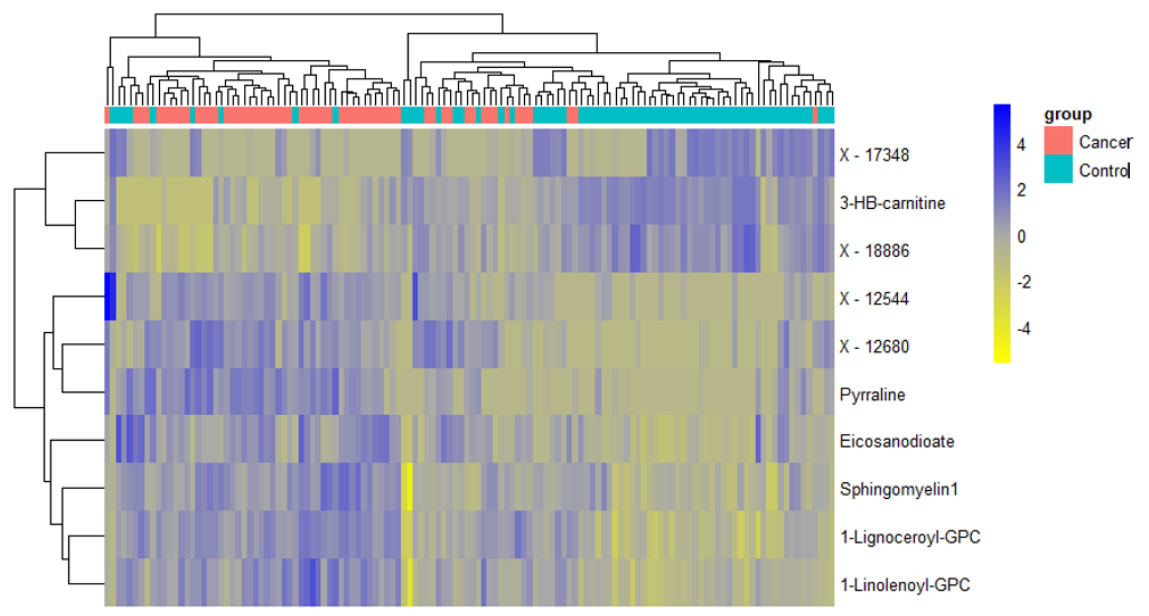
Figure 8. Hierarchical clustering using the top 10 discriminatory metabolites for the detection of early-stage endometrial cancer in the training set ( n = 102, cancers = 47, controls = 55) based on mean decreasing accuracy using random forest classification algorithm. The difference in intensities of the top 10 metabolites by cancer-control status is shown. Each coloured cell in the map represents scaled/relative concentration of indicated metabolite. Metabolites are clustered along the vertical axis while subjects are clustered along the horizontal axis. Metabolites starting with X are unnamed; the pathways of these are unknown. Table 4. Random forest diagnostic accuracy developed based on the training set made from 80% of